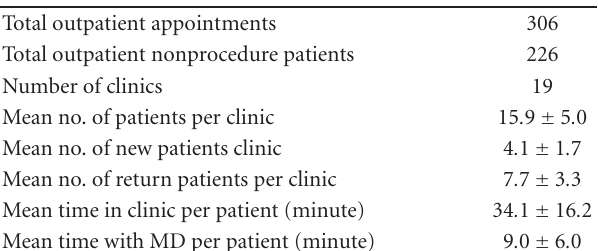
Table 1: Demographic characteristic of outpatient urology clinic patient population.